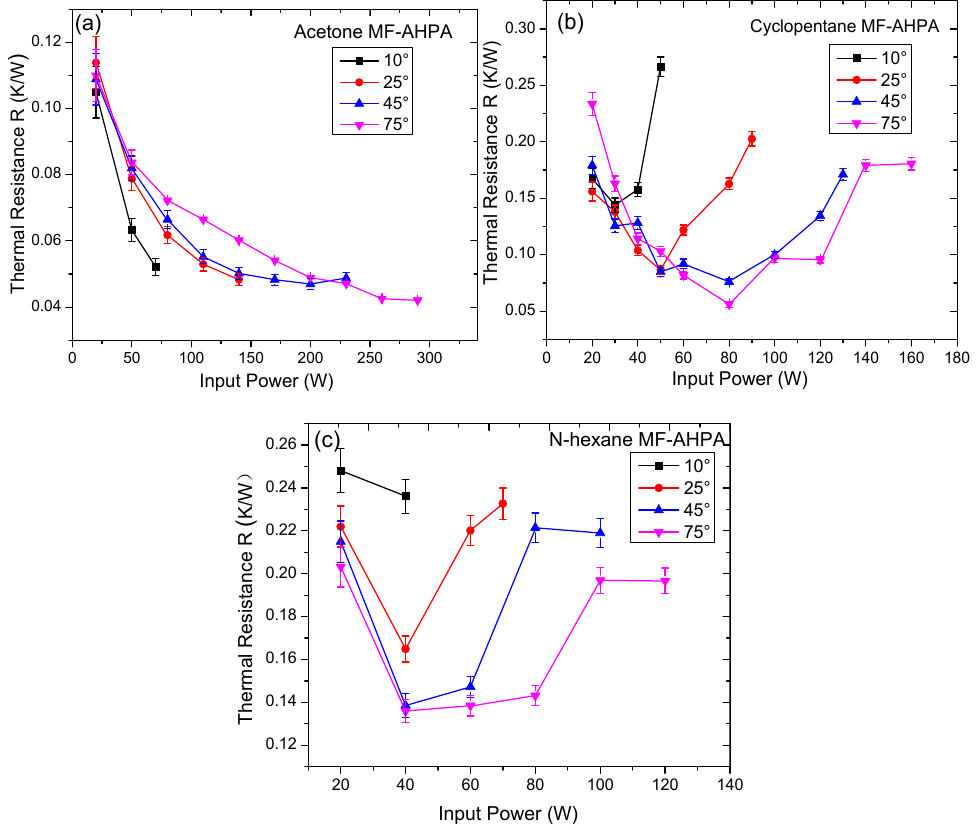
Figure 10. Effect of inclination angle on thermal resistance of ( a ) acetone MF-AHPA; ( b ) cyclopentane MF-AHPA; and ( c ) n-hexane MF-AHPA.